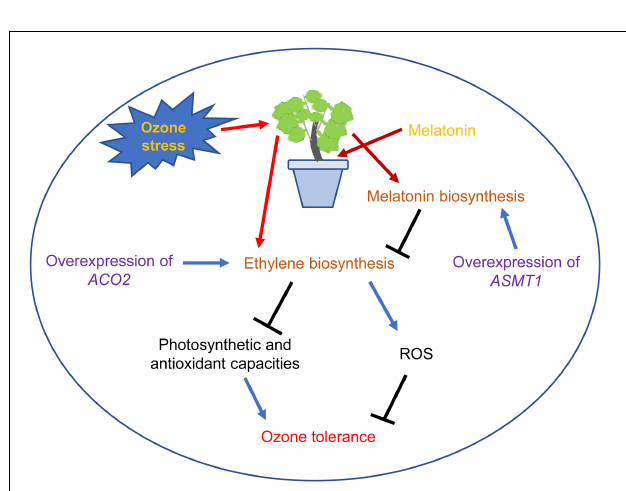
FIGURE 7 | A schematic model showing the mechanisms of MT alleviating O 3 stress in grape leaves. The arrow denotes increases and bar denotes